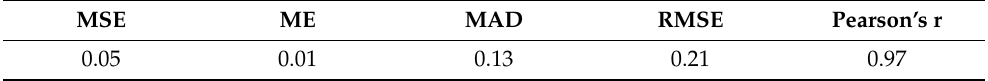
Table 8. Evaluation metrics of HbA1c for the single PD reflection-type wrist Table 9. Evaluation metrics of SpO 2 for the single PD reflection-type wrist model.